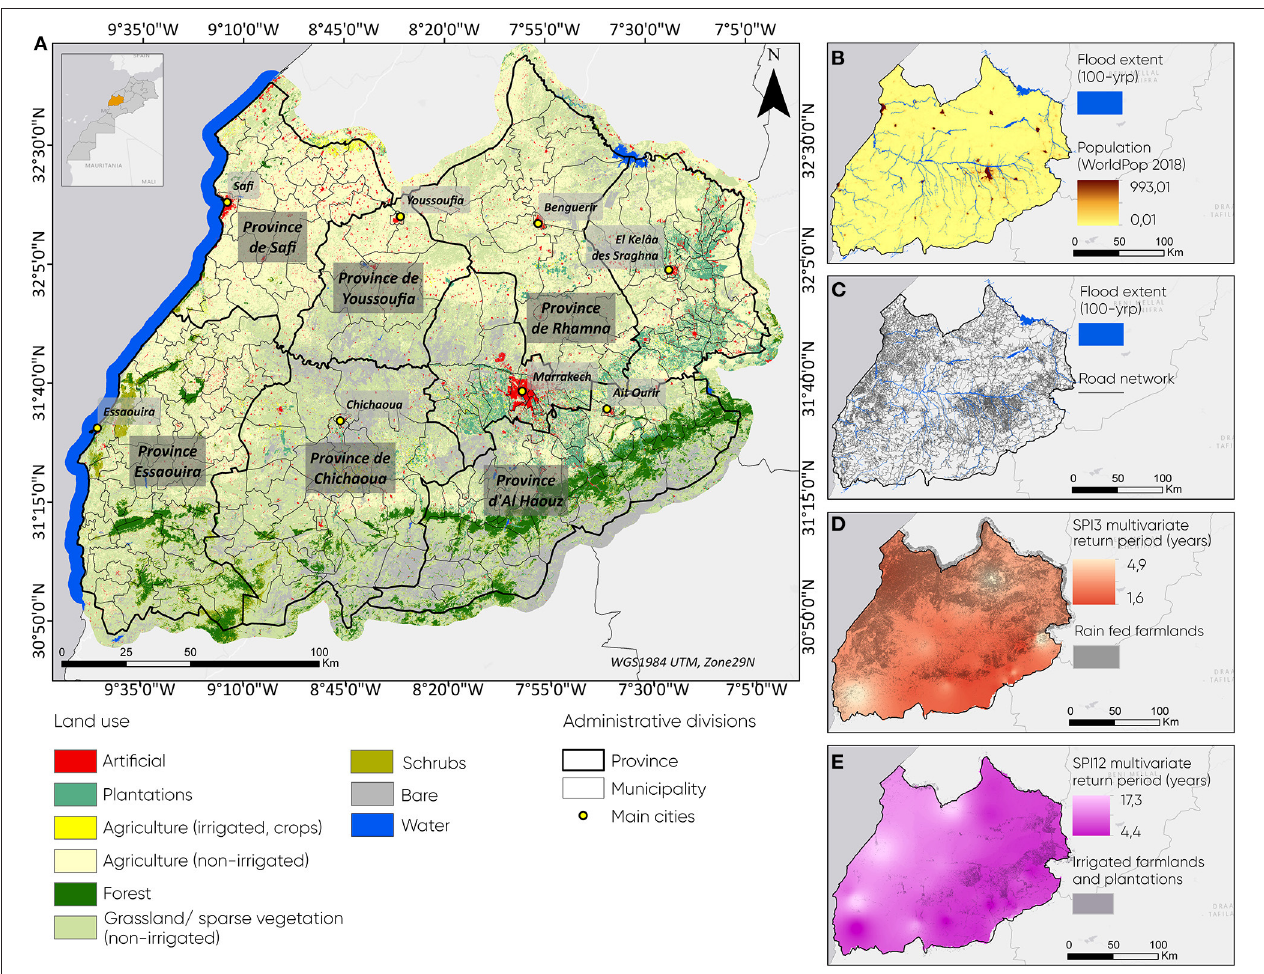
FIGURE 1 | Marrakech-Safi region: land use-land cover (data source: Sentinel 2 monthly composite; reference year: 2018) (A) , 100-yrp flood event over population distribution (B) and road infrastructure network (C) , SPI12 multivariate drought event and irrigated farmlands and plantations (D) , and SPI3 multivariate drought event and rain fed farmlands (E) . Source: authors. For further information on data sources and processing please see Section Multi-risk Hazard